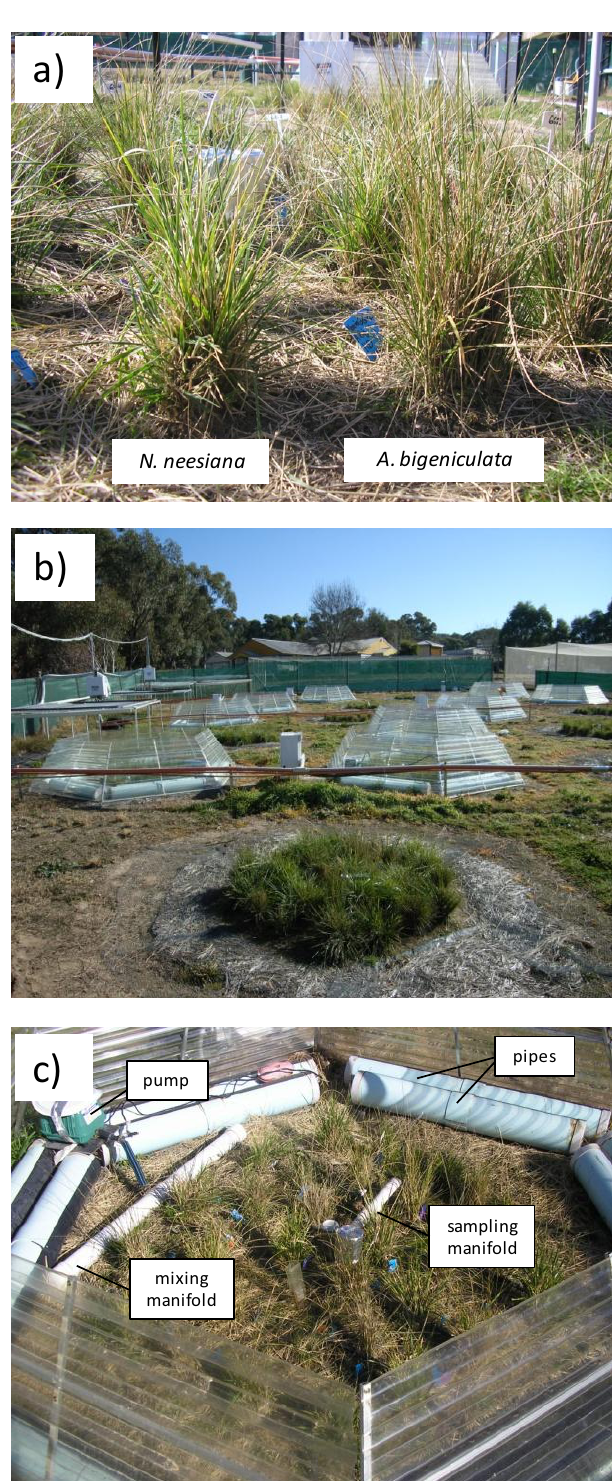
Figure 2. The study species and experimental study site. ( a ) Ramets of Nassella neesiana and Austrostipa bigeniculata growing in a study plot. ( b ) The experimental site at Black Mountain, Australian Capital Territory (ACT), Australia, showing open-top chambers. The view is to the west. ( c ) Close-up of the inside of a chamber, showing pipes (containing water) arranged around the outside of the plot, along with the CO manifold and sampling